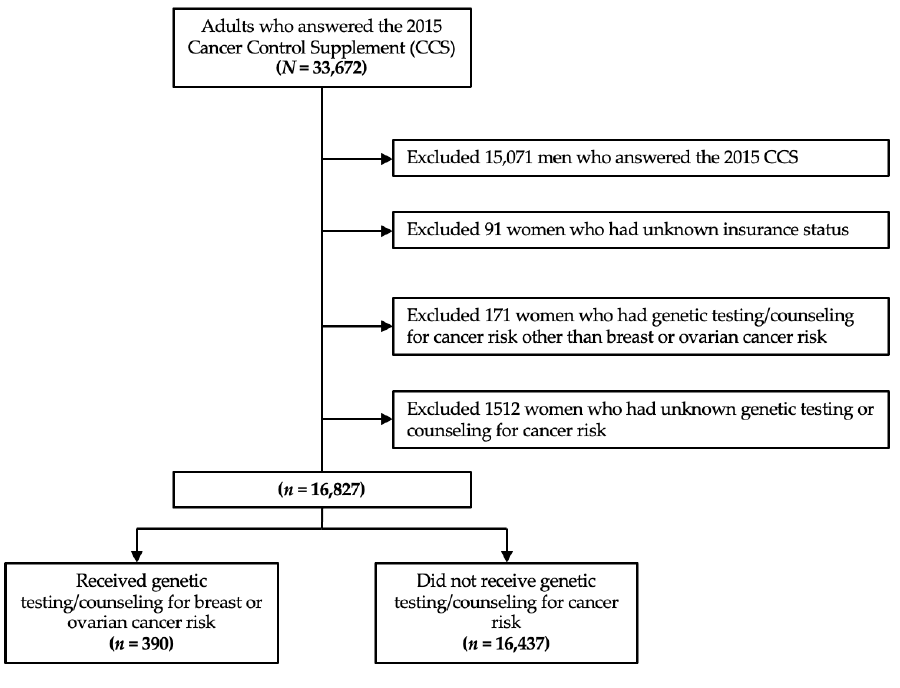
Figure 1. Study flow diagram. Table 1. Baseline characteristics.